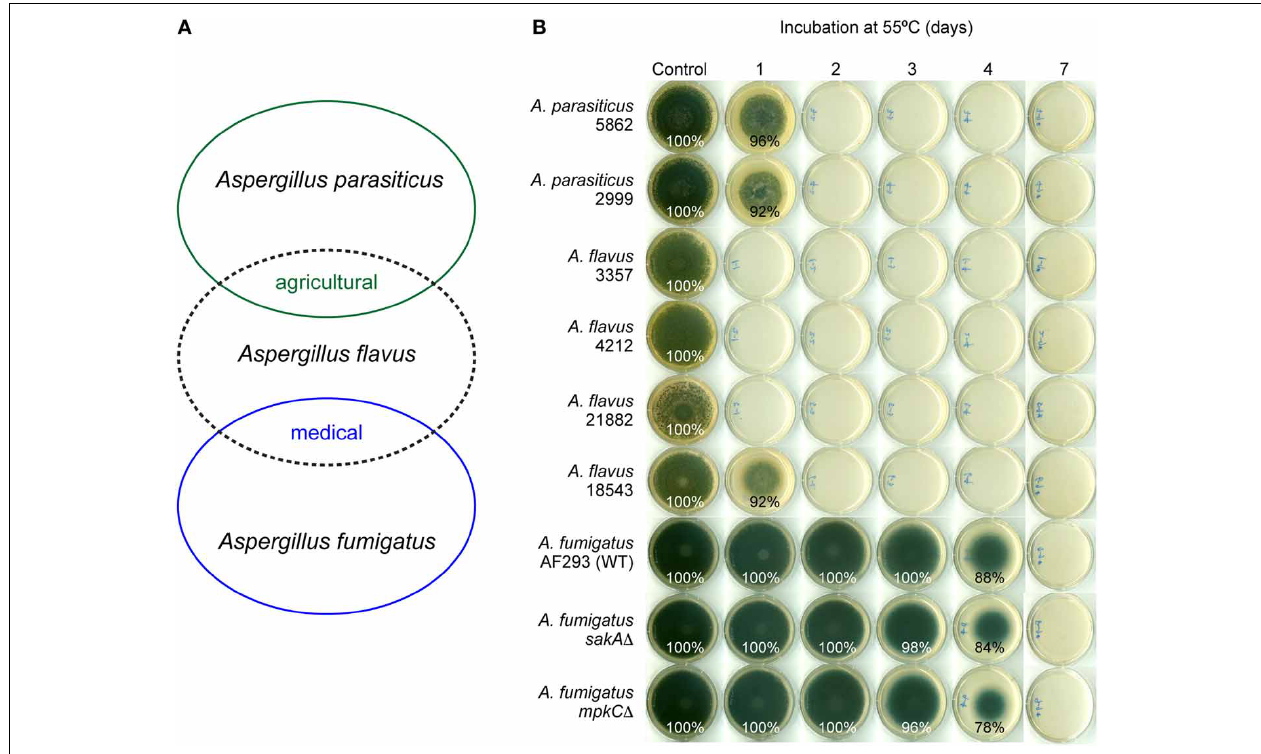
FIGURE 2 | Differential sensitivity of Aspergillus strains to high temperature (55 ◦ C). (A) Scheme showing A. flavus shares agro-infectivity with A. parasiticus , while it shares human-infectivity with A. fumigatus . (B) Fungal plate bioassay showing A. fumigatus strains were more tolerant to high temperature (55 ◦ C) compared to